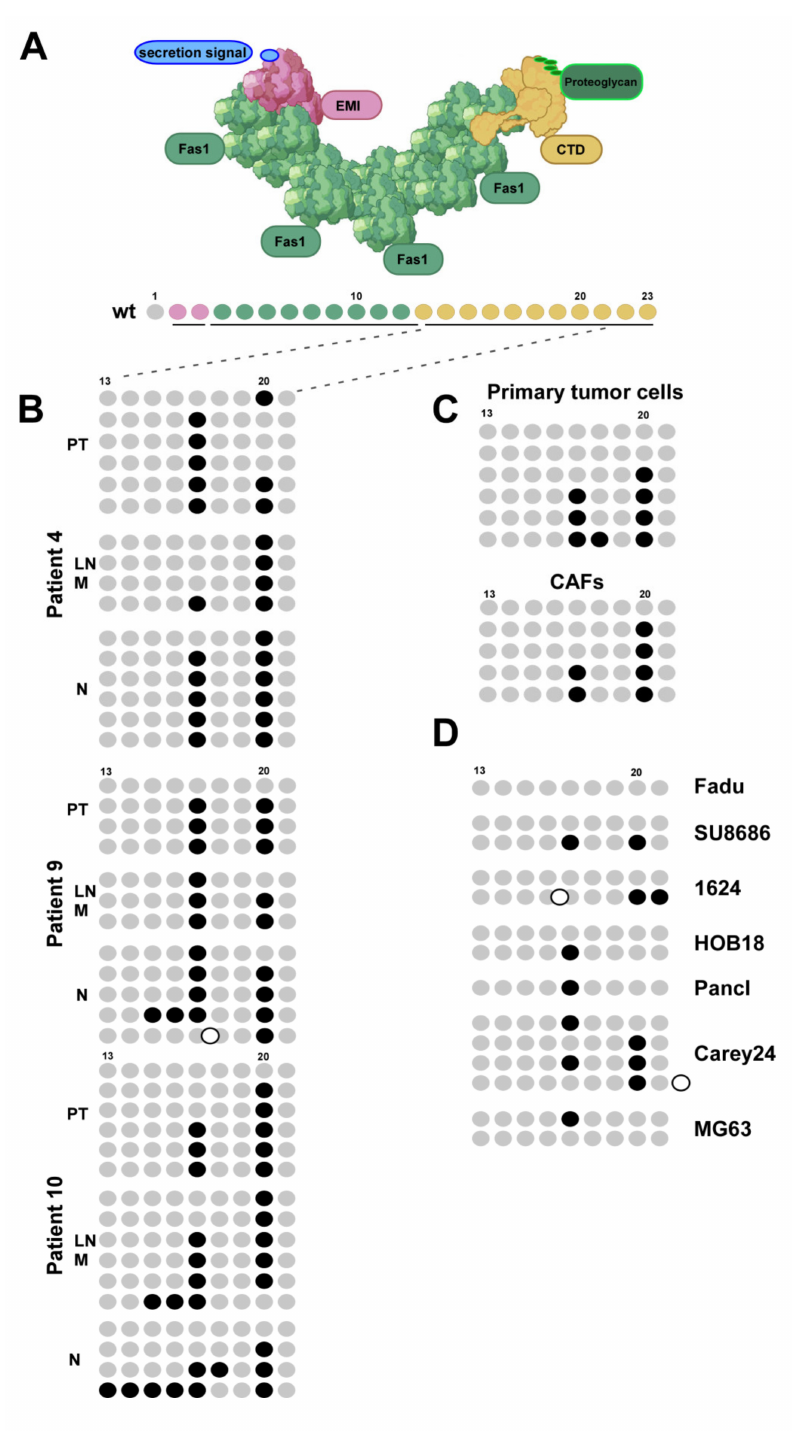
Figure 5. HNC patients express various OSF-2 isoforms differing in their C-terminal domain. ( A ) Pro- posed protein domain organization of OSF-2 (modified from [40]). The canonical sequence (wt)